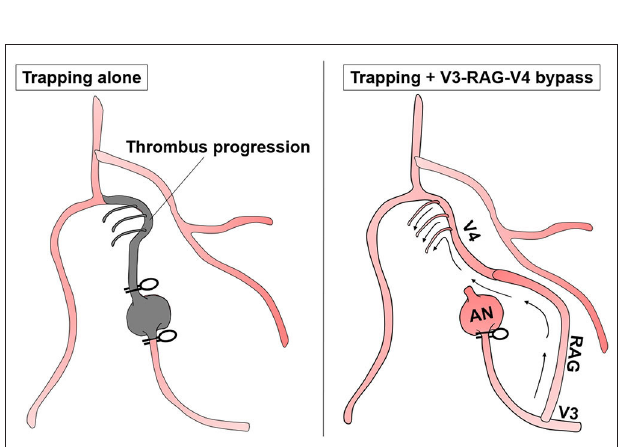
FIGURE 4 | Schematic of the treatment strategy for case 2.